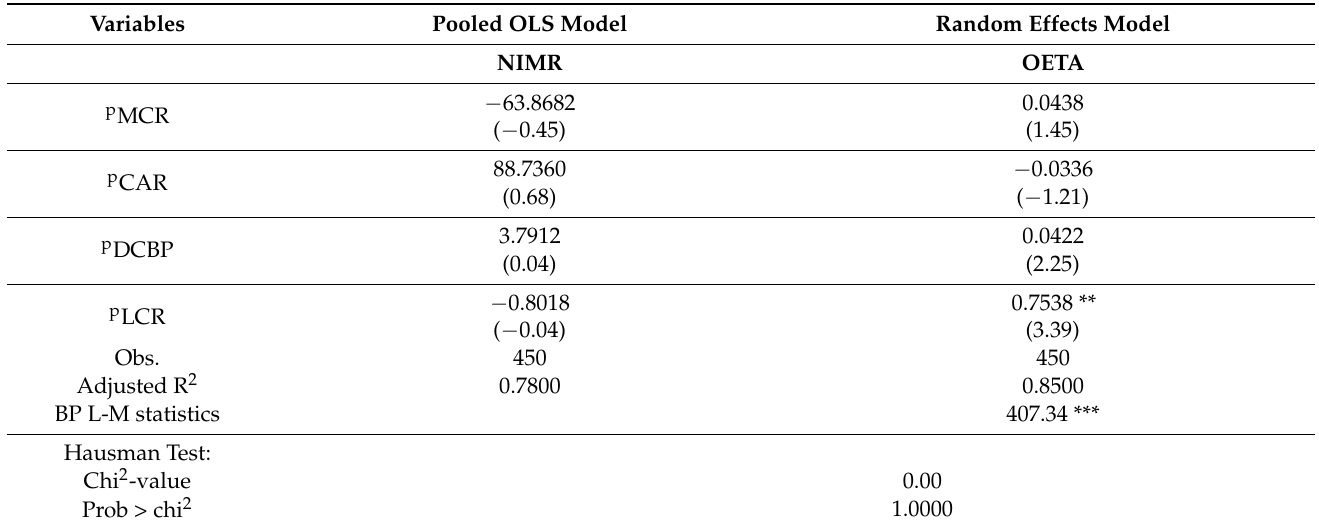
Table A3. Robustness Test